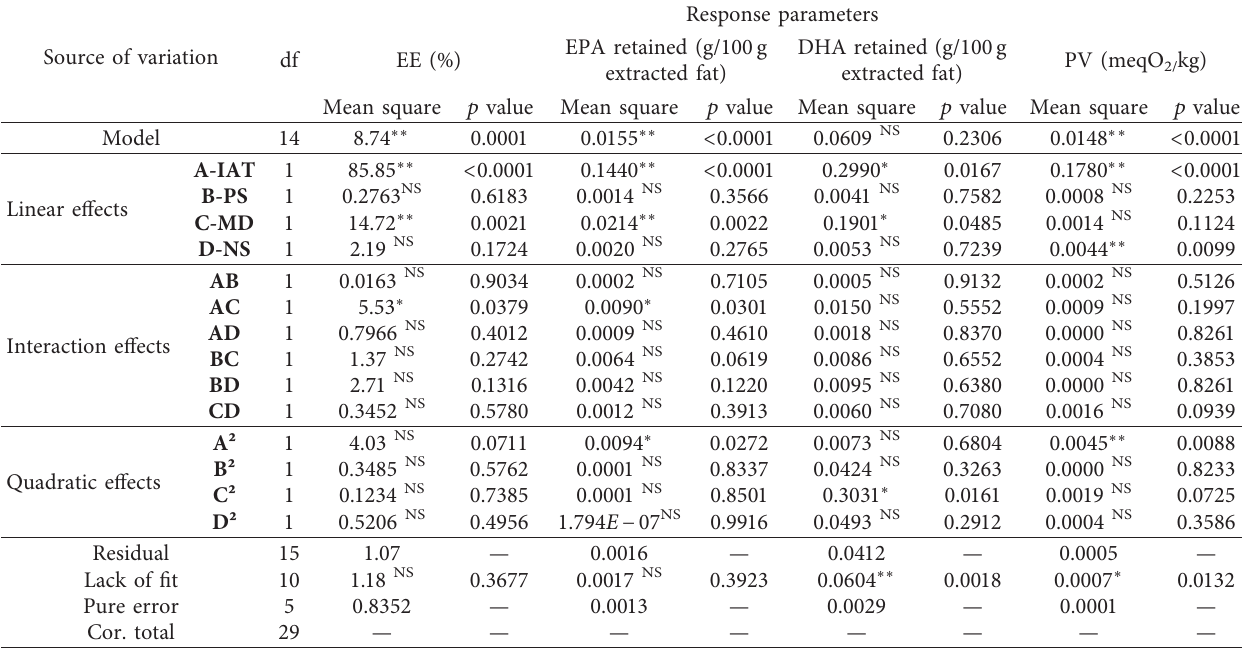
Table 4: Analysis of variance (ANOVA) of the predicted second-order polynomial model for spray drying conditions’ impact on response parameters.